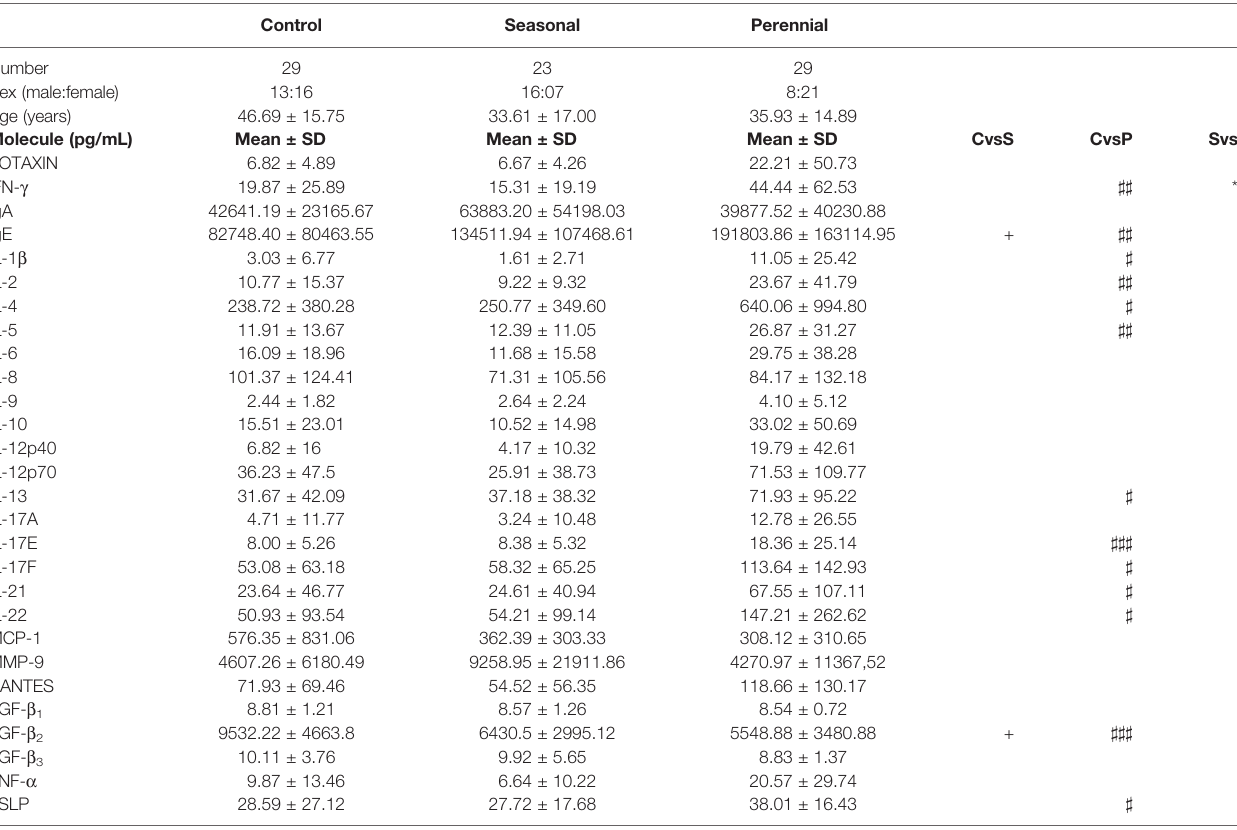
TABLE 4 | Obtained concentrations for soluble molecules analyzed in tears.